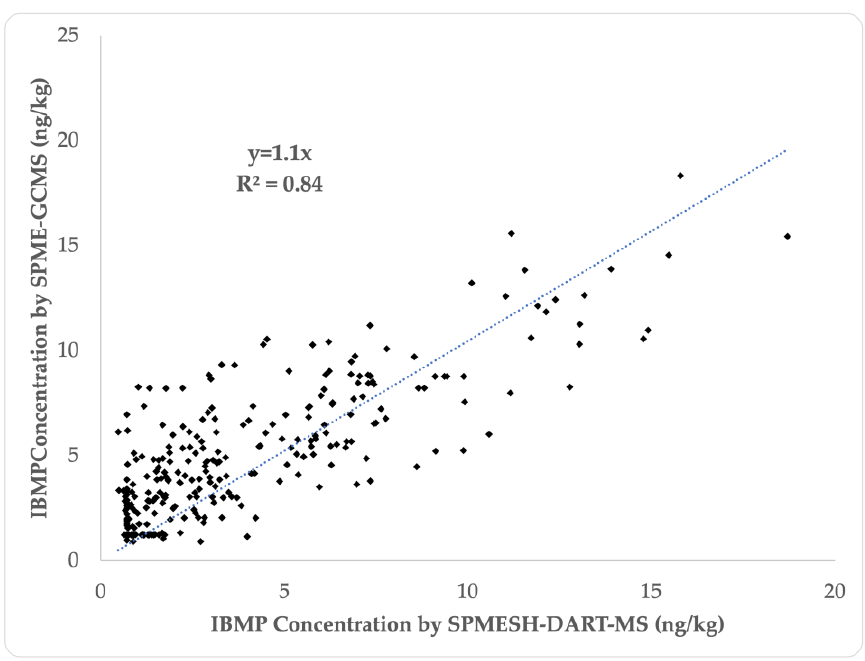
Figure 4 . Correlation between IBMP measured by SPMESH-DART-Orbitrap MS/MS and HS-SPME- GC-MS. Undetectable values were set to the square root of the LOD (SPME-GC-MS = 1.2 ng/kg, SPMESH-DART-MS = 0.71 ng/kg).